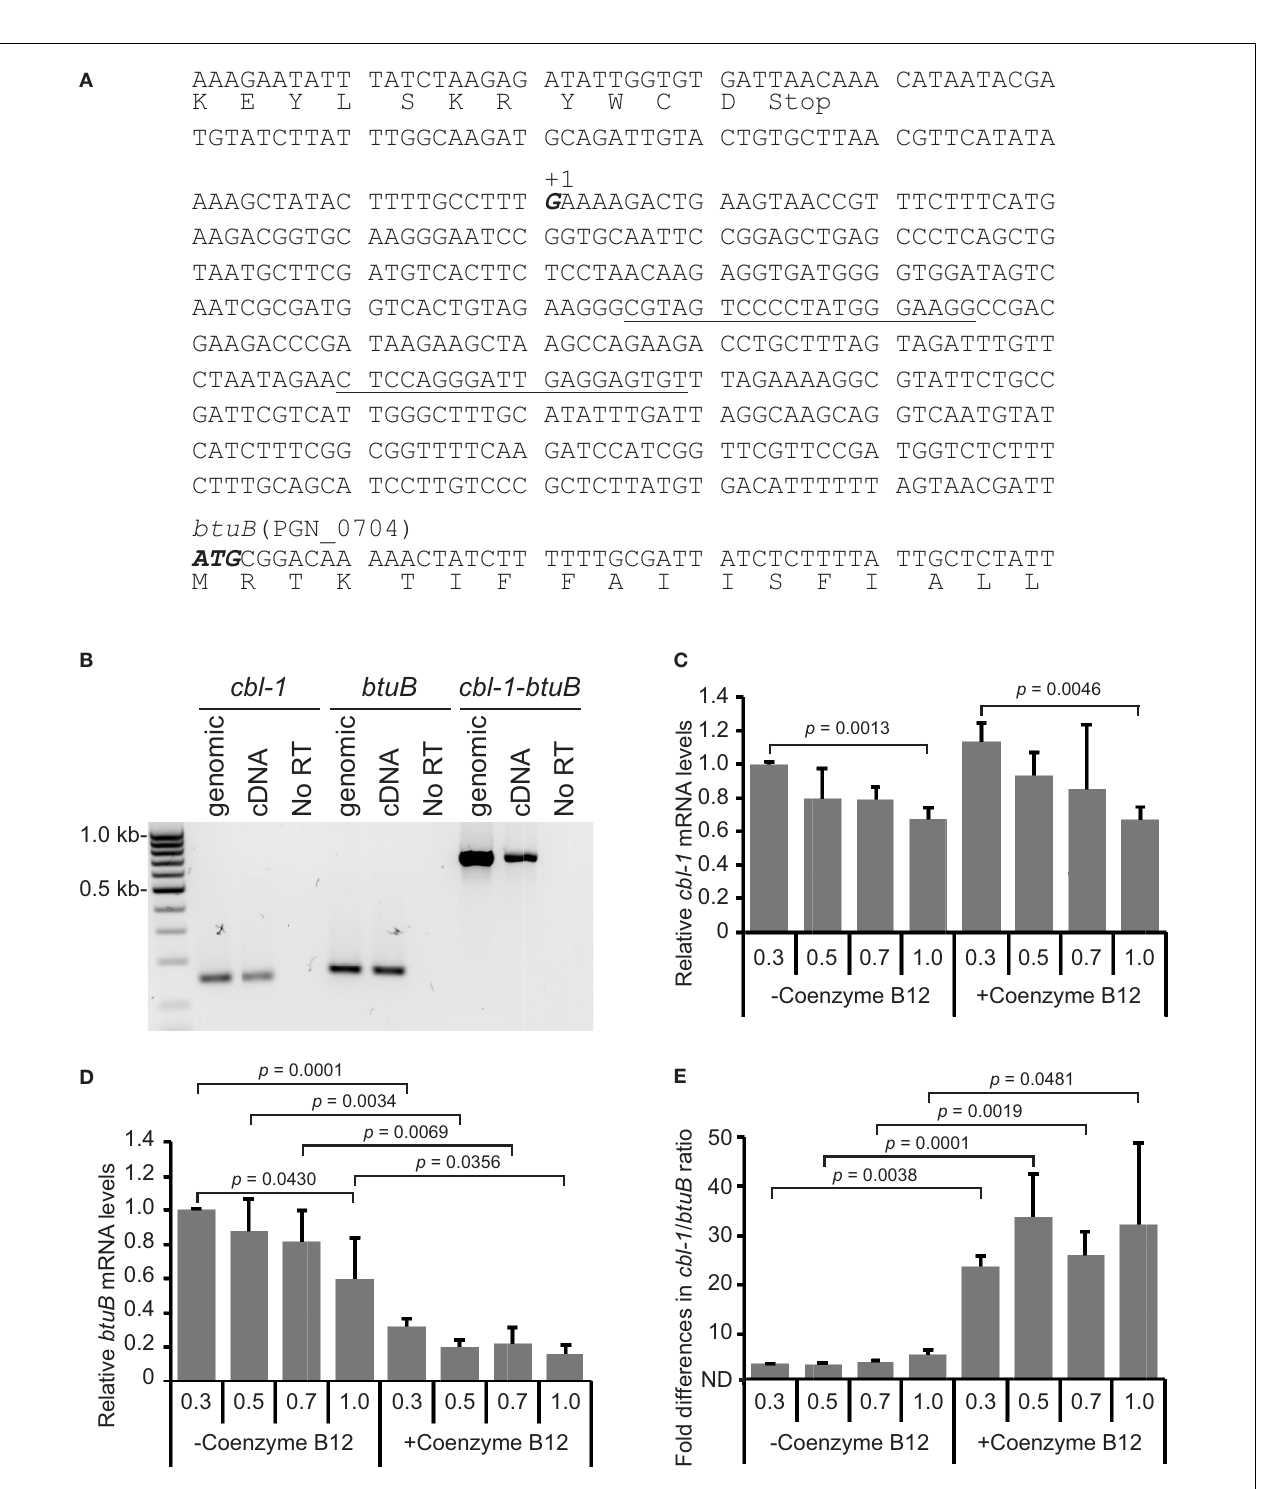
and btuB .The presence of an amplicon with cDNA demonstrates co-transcription of cbl-1 and btuB .The No RT lanes are controls without reverse transcriptase. (C) cbl-1 levels were not affected by 100 µ M Coenzyme B12. (D) btuB transcripts were significantly reduced by culture with 100 µ M Coenzyme B12. (E) Ratio of cbl-1 to btuB mRNA copy number. Results in (C–E) are means with standard deviation of three biological replicates ( n =